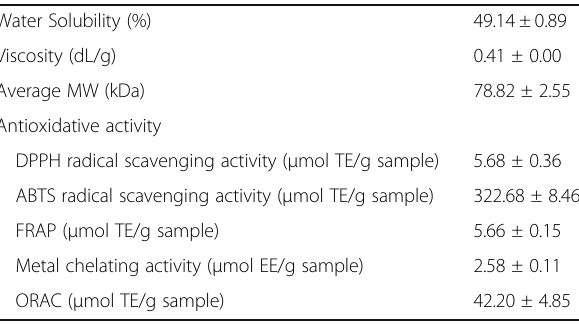
Table 1 Water solubility, viscosity, average molecular weight (MW) and antioxidative activity of COS-L from squid pen